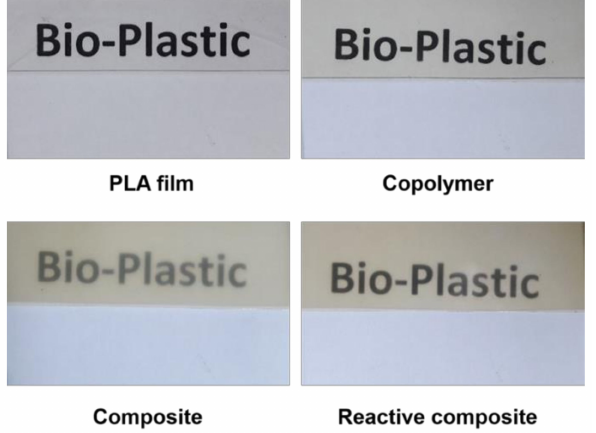
Figure 5. Photographs of 0.4 mm thick films of PLA, PLA-PEG block copolymer, copolymer composite, and reactive copolymer composite. Table 4. Tensile data of various bio-based and petroleum-based polymers, together with the similar PLA-based block copolymers prepared by different synthesis